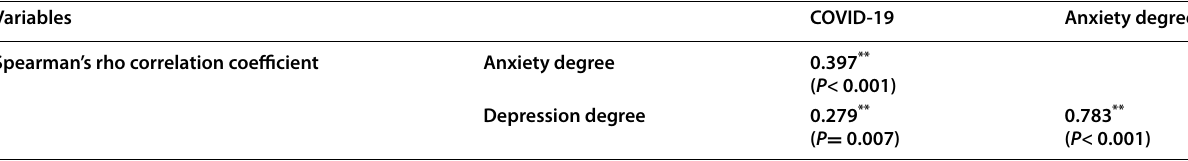
** P value < 0.01 (highly significant)